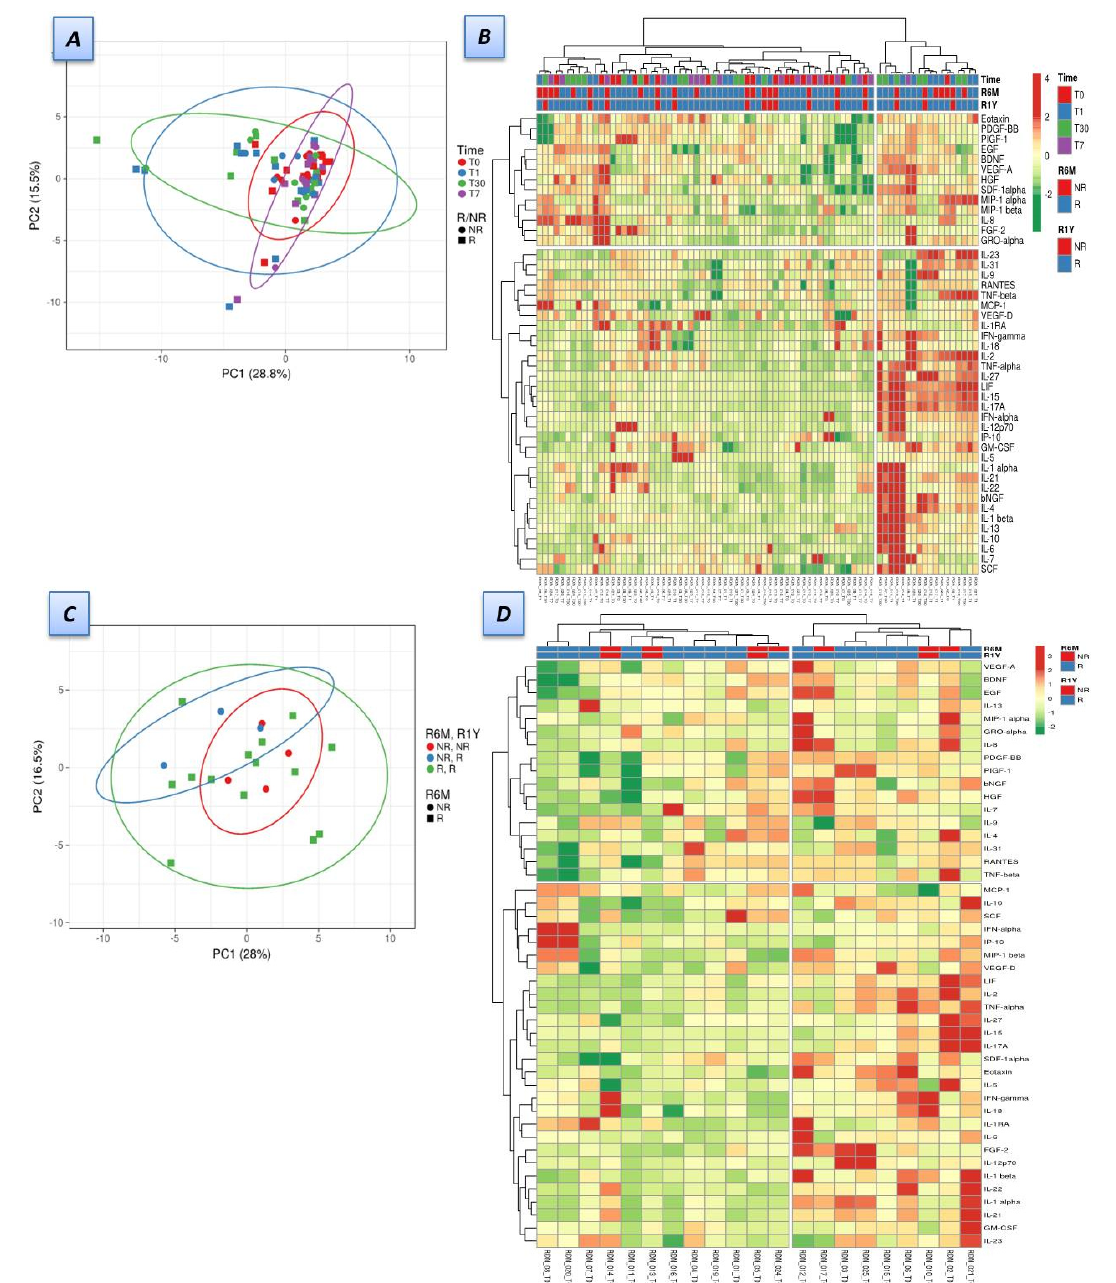
Figure 2. Distribution of cytokines, chemokines, and growth factors, according to renal denervation response, at six months and one year. ( A ) Principal component analysis for the distribution of cytokines, chemokines, and growth factors in R/NR and R1Y/NR1Y at the four analyzed time points (D0, D1, D7 and D30—see text). ( B ) Heatmap for plasmatic cytokines, chemokines, and growth factors in R/NR and R1Y/NR1Y, at the four time points. ( C ) Principal component analysis for the distribution of cytokines, chemokines, and growth factors in R/NR and R1Y/NR1Y, at baseline ( D ) Heatmap at baseline for cytokine, chemokine, and growth factor quantification in R/NR and R1Y/NR1Y. Bars at the top of the heatmaps represent each patient individualized ( B , D ), the time point of the analysis ( D ) and the groups according to response (R/NR—six months; R1Y/NR1Y—one year), in accordance with the legend on the right side of the figure. Numbers at the bottom of the heatmaps represent patient case number identifiers. RDN—renal